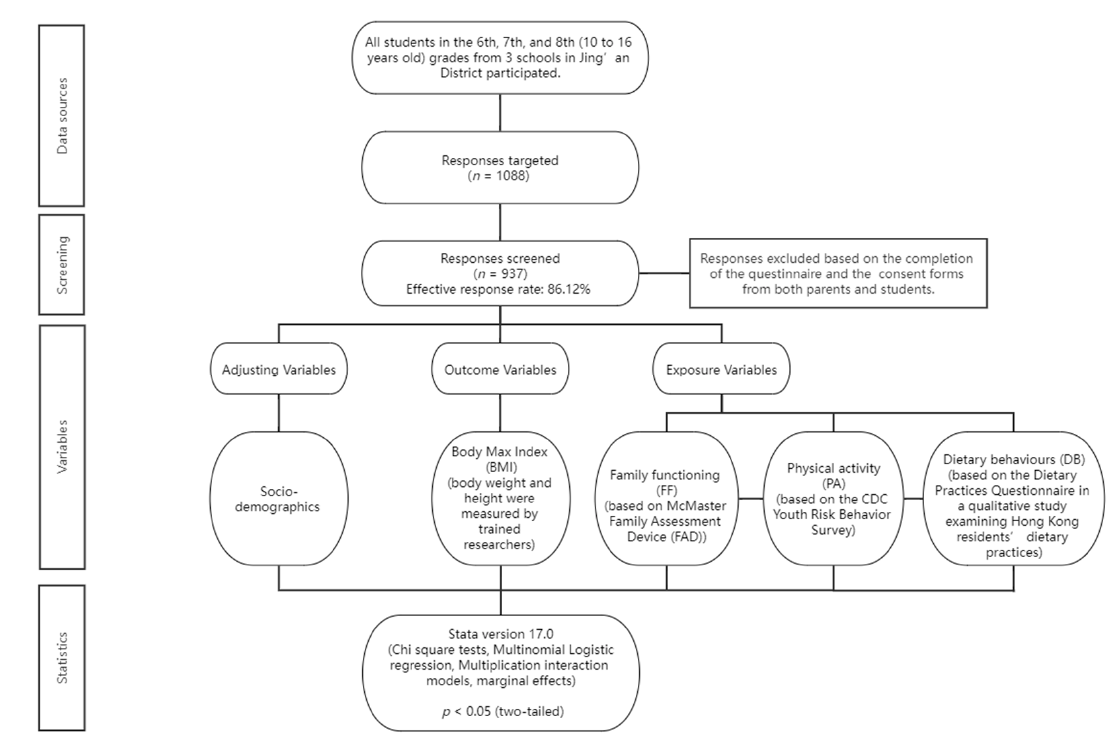
Figure 1. Schematic graph of the study design.